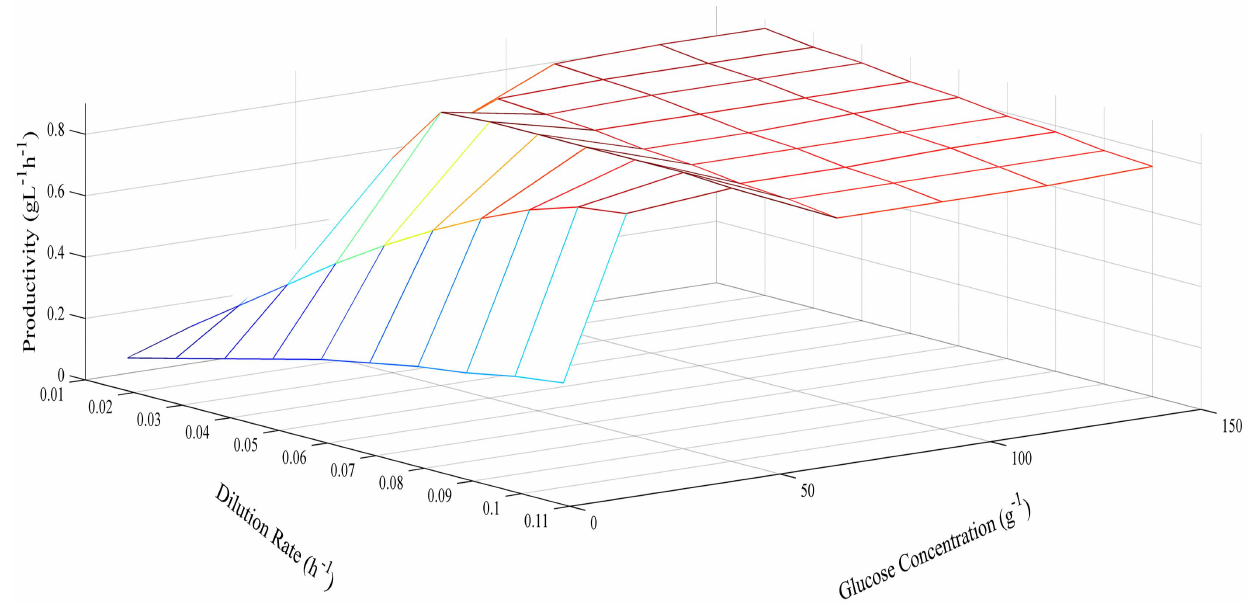
Figure 7. Simulated effects of dilution rate and glucose feed concentration on butyrate productivity. Color differences indicate